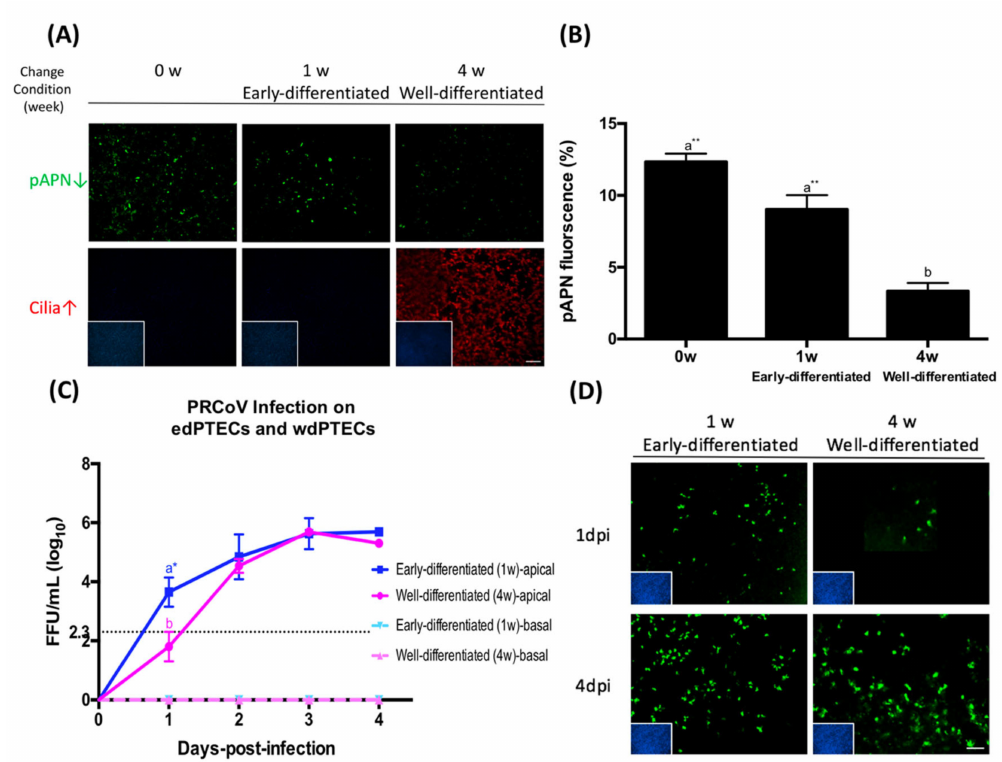
Figure 4. The expression of pAPN is associated with porcine tracheal epithelial cells (PTECs) di ff erentiation. ( A ) PTECs were fixed after 0, 1, and 4 weeks of change condition, pAPN protein location in porcine airway epithelia was determined by using immunofluorescence staining for pAPN (green), β -tubulin (red), and DAPI (blue). ( B ) To quantify the expression of pAPN, the areas containing green fluorescent were determined by ImageJ; ( C ) replication of PRCoV in early di ff erentiated (ed) and well-di ff erentiated (wd) porcine airway epithelial cell cultures. EdPTECs and wdPTECs were inoculated with PRCoV from the apical side at 1 × 10 3 FFU. Viruses released from the apical side were harvested at di ff erent time points and titrated by focus-forming assay in ST cells. The results were shown as means ± SEM of nine PTECs from three independent donors. Each sample was processed with two technical replicates. The dashed line was the detection limit for the foci-forming assay. Statistical analysis was performed by one-way ANOVA and followed by Tukey’s multiple comparisons test. a, b significant di ff erences between groups are indicated with di ff erent letters (** p < 0.01, * p < 0.05). ( D ) EdPTECs and wdPTECs were fixed on 1- and 4-days post infection, respectively. EdPTECs and wdPTECs were stained for PRCoV nucleocapsid (green) and DAPI (blue). Scale bars, 25 µ